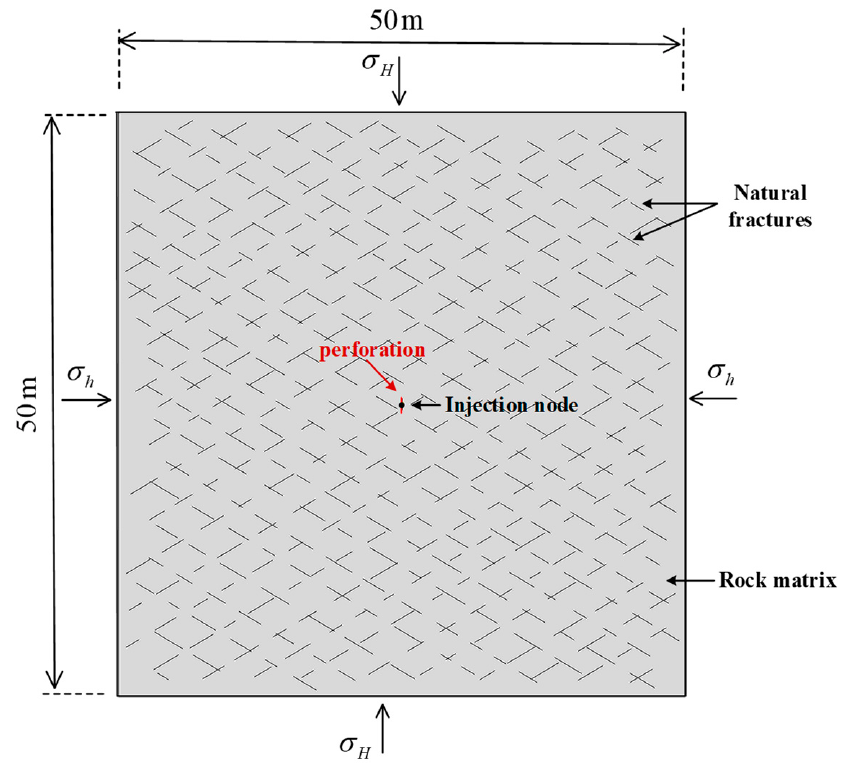
Figure 6. Schematic representation of discontinuous natural fractures network model.